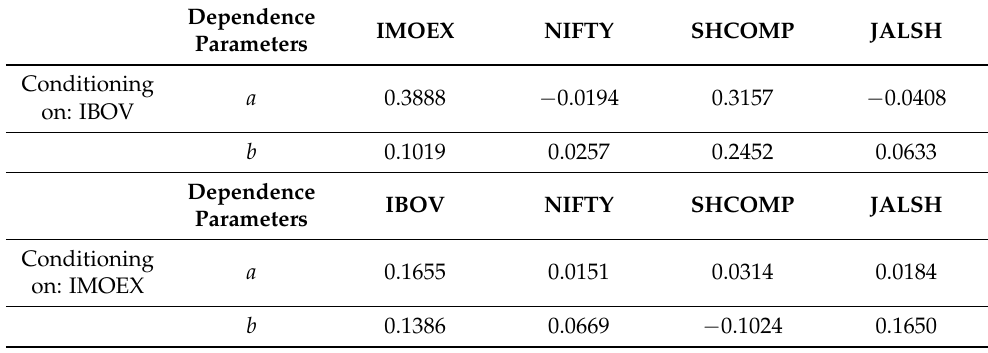
Table 3. Dependence structure parameter estimates of the CMEV